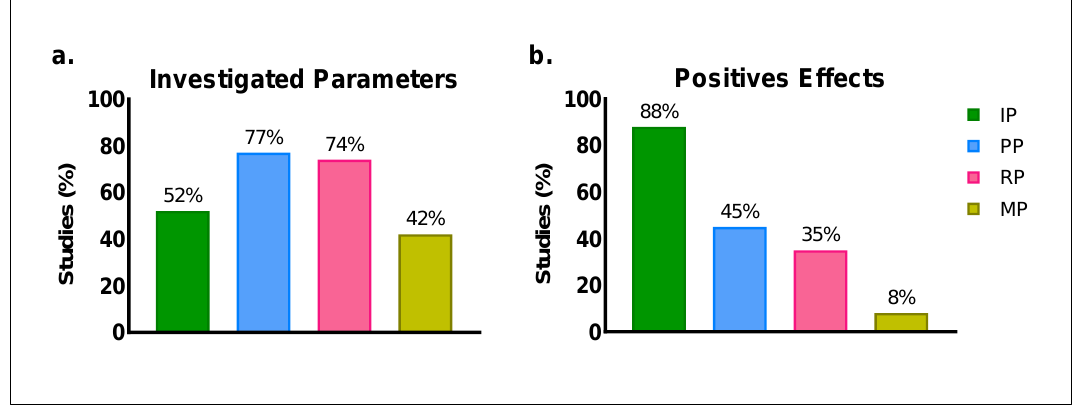
Figure 5. Percentage of studies on the effects of inspiratory-muscle warm-up on inspiratory parameters (IP); performance parameters (PP); respiratory parameters (RP); and metabolic parameters (MP). ( a ) Investigated parameters. ( b ) Positive effects.